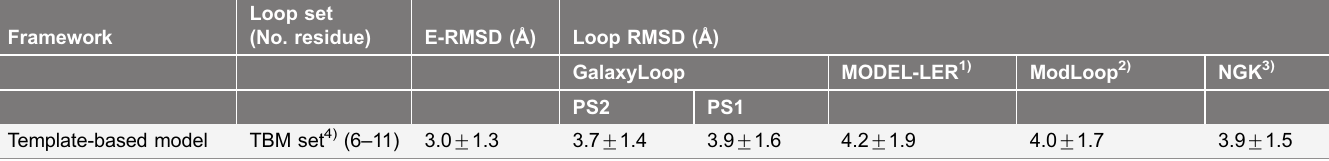
Table 2. Comparison of loop modeling results on the test set of template-based models.